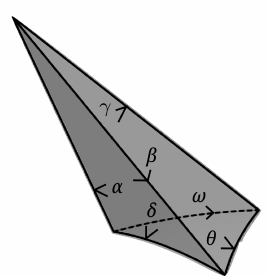
Figure 7: If D is a dodecahedron, T is the hyperbolic tetrahedron with dihedral angles α = π /5, β = π /3, γ = δ = ω = π /2 and θ = π